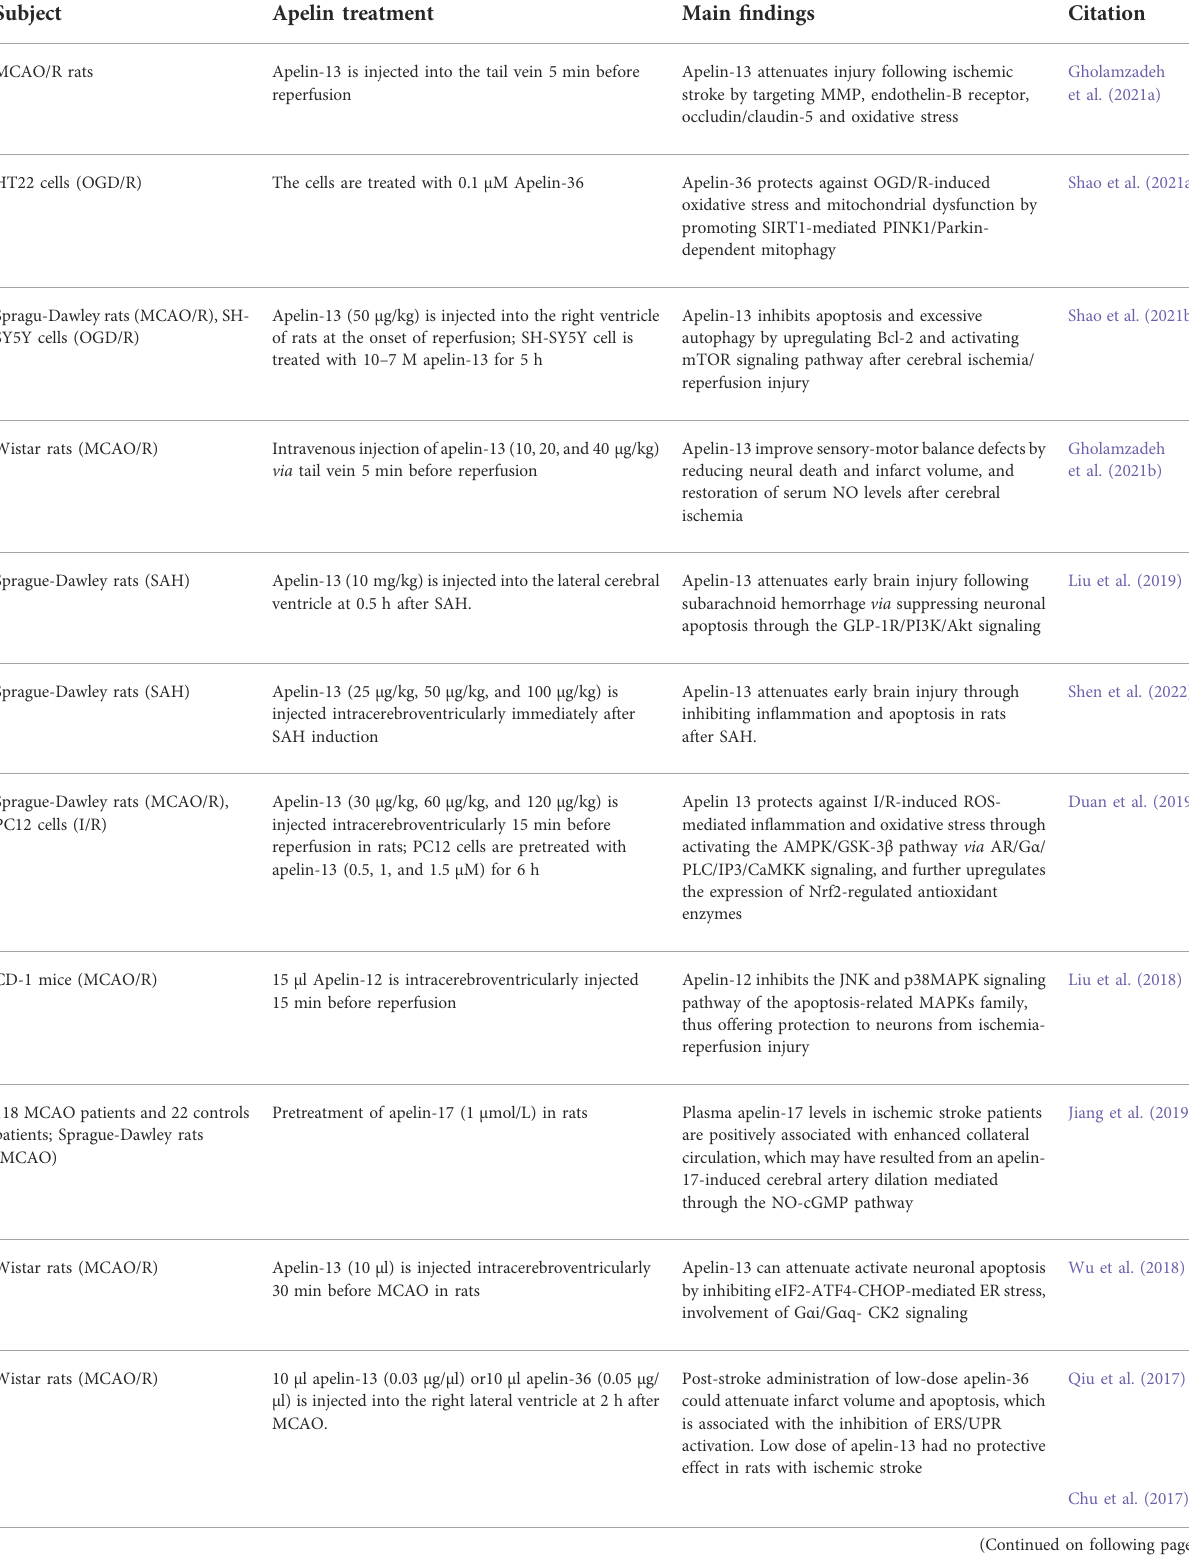
TABLE 2 The evidence from experimental trials demonstrating the role and mechanism of apelin in